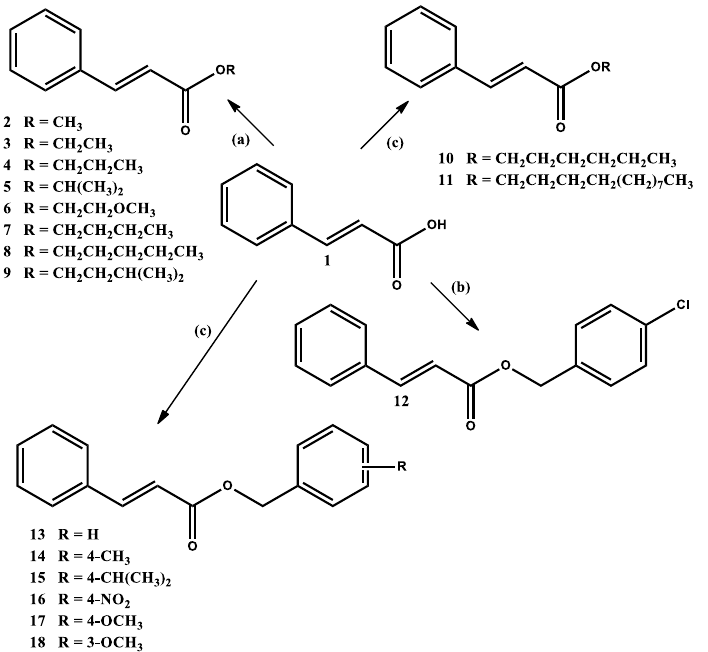
Table 1. Larvicidal activity of cinnamic acid and its derivatives against Ae . aegypti fourth instar larvae after 24 h of exposure.